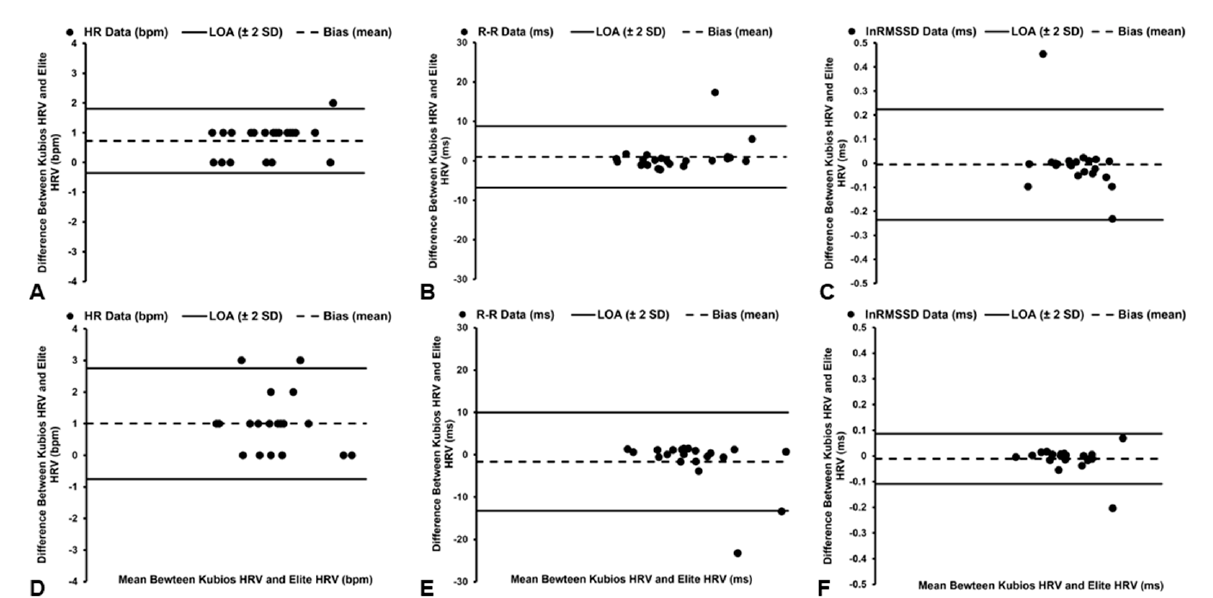
Figure 4. Bland–Altman plots demonstrating the mean bias and limits of agreement (LoA) of heart rate (HR, A ), R–R interval ( B ), and natural log of root mean square of successive differences (lnRMSSD, C ) data in the supine position and the mean bias and limits of agreement (LoA) of HR ( D ), R–R interval ( E ), and lnRMSSD ( F ) data in seated position when utilizing Low artifact-correction level.